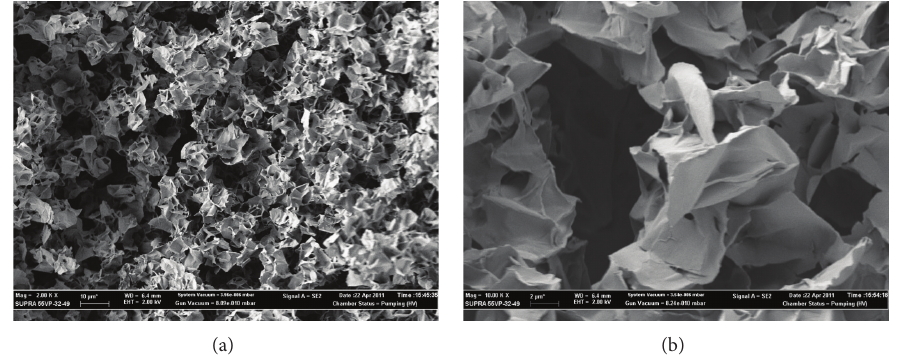
Figure 9: SEM microphotographs of PDL+PDL-HEMA-based macroporous materials: (a)—magnification × 2000; (b)—magnification ×